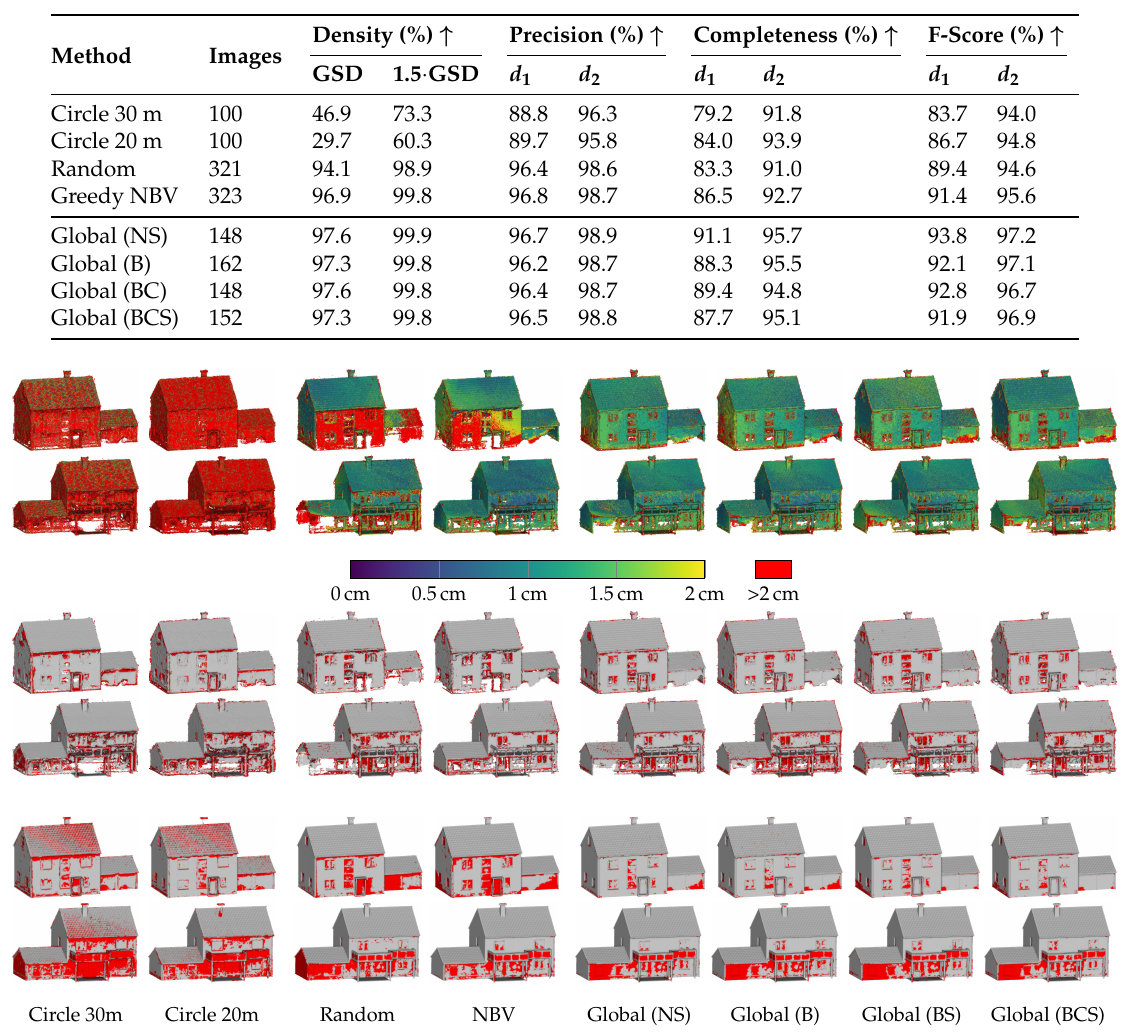
Table 3. Quantitative evaluation of the reconstruction results for the synthetic scene obtained from different path planning methods. We report the point density as the percentage of reconstructed points that have a shorter distance towards their nearest neighbor than the demanded GSD = 2cm, as well as one and a half times the distance (1.5 · GSD = 3cm). The reconstruction errors are stated for d 1 = 5cm and d 2 = 10cm. The proposed globally optimized paths are superior to the baseline methods, while featuring a shorter path. The severely limited free airspaces due to different semantic restrictions lead only to a slight drop in the reconstruction quality.